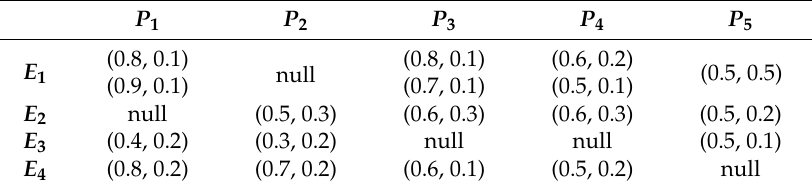
Table 4. The raw reputation rating matrix M 3 .